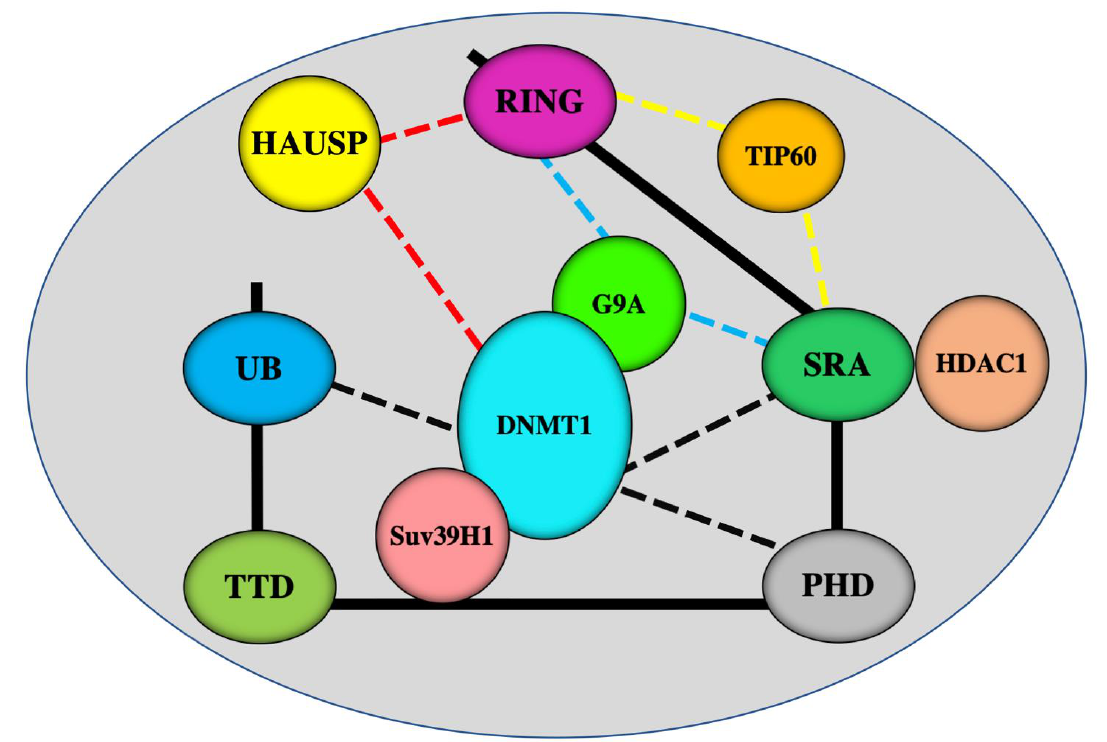
Figure 2. Schematic representation of interactions of UHRF1 domains with various epigenetic writers and erasers. UHRF1 uses its SRA domain to interact with DNMT1 [15 – 17] and HDAC1 [18]. UHRF1 can also interact with DNMT1 through PHD [36] and ubiquitin-like domain (UBL) [37,38] domains (black lines). HAUSP (herpes virus-associated ubiquitin-specific protease) interacts with both UHRF1 and DNMT1 [39,40] (red lines). Via its C-terminal region which covers the SRA and RING domains, UHRF1 interacts with histone methyltransferases G9a [21] (blue lines) and histone acetyltransferase Tip60 [19,20]. UHRF1 can interacts with another histone acetyltransferase Suv39H1 [41]. DNMT1 can also interact with Suv39H1 and G9a [42].